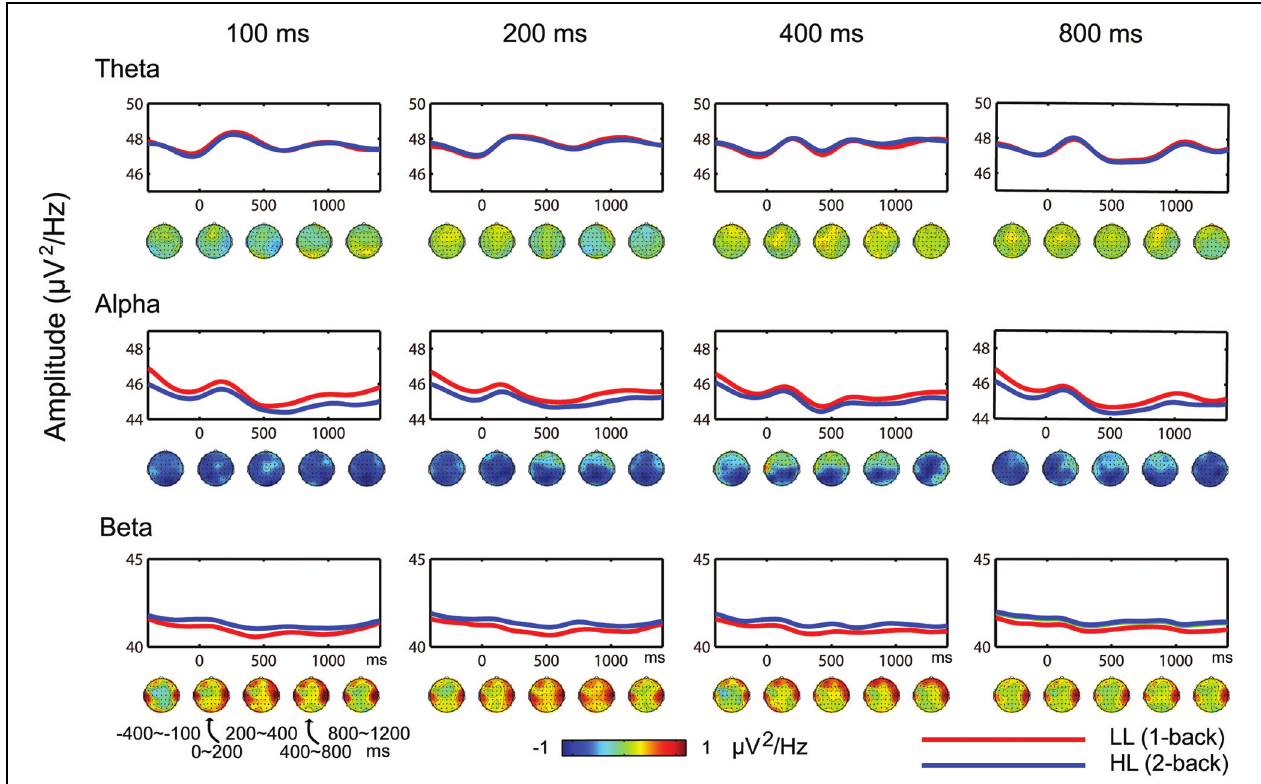
FIGURE 4 | Temporal dynamic activity of theta, alpha, and beta oscillations for 100-, 200-, 400-, and 800-ms duration conditions in the time interval from − 400 to 1400 ms. Red and blue lines indicate the mean spectral power of nine clusters. The topographies indicate the distributions of the HL minus LL power difference during the time intervals of − 400 to − 100, 0 to 200, 200 to 400, 400 to 800, and 800 to 1200